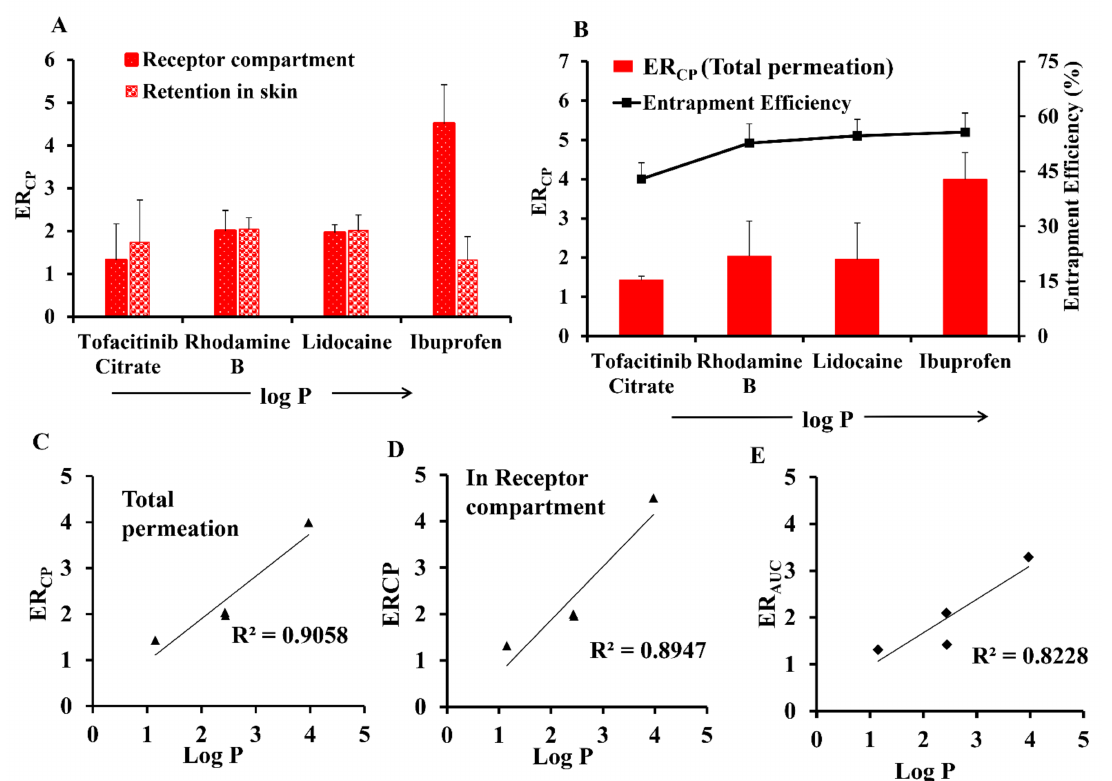
Figure 5. ( A ) Effect of logP of drugs delivered through proposomes on amount retained and amount permeated. ( B ) Effect of logP on entrapment efficiency and ER CP . ( C ) Linear regression of plot of logP vs ER CP for total permeation. ( D ) Linear regression of plot of logP vs ER CP for amount of drug permeated into receptor compartment. ( E ) Linear regression of plot of logP vs ER AUC . The linear regression analysis was based on ibuprofen, lidocaine, tofacitinib citrate, and rhodamine B, while ibuprofen sodium was